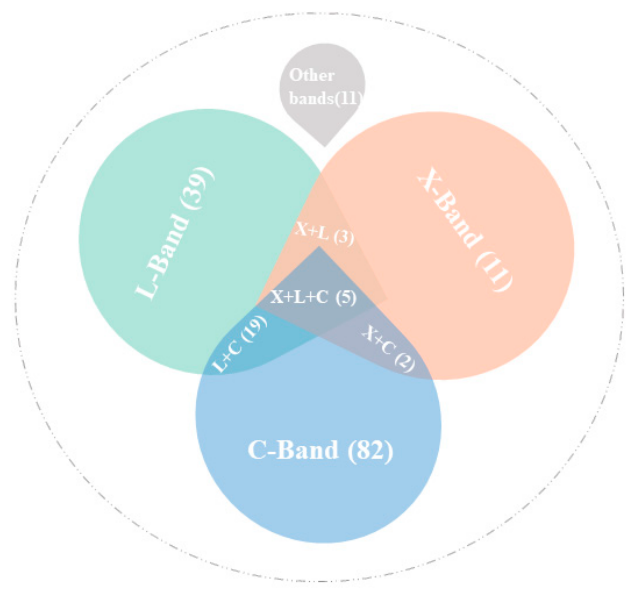
Figure 9. Number of studies in each frequency bands. The other bands group corresponds to less used bands such as Ka, S and P bands, with which some airborne SAR sensors are equipped.